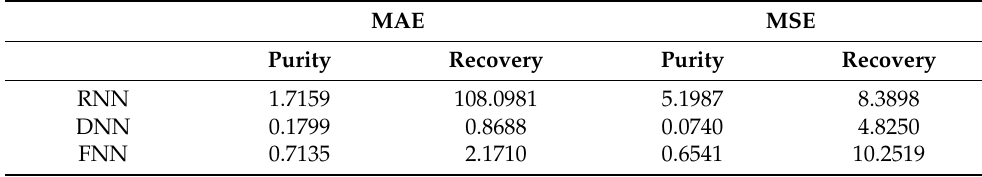
Table 5. Simulation performance